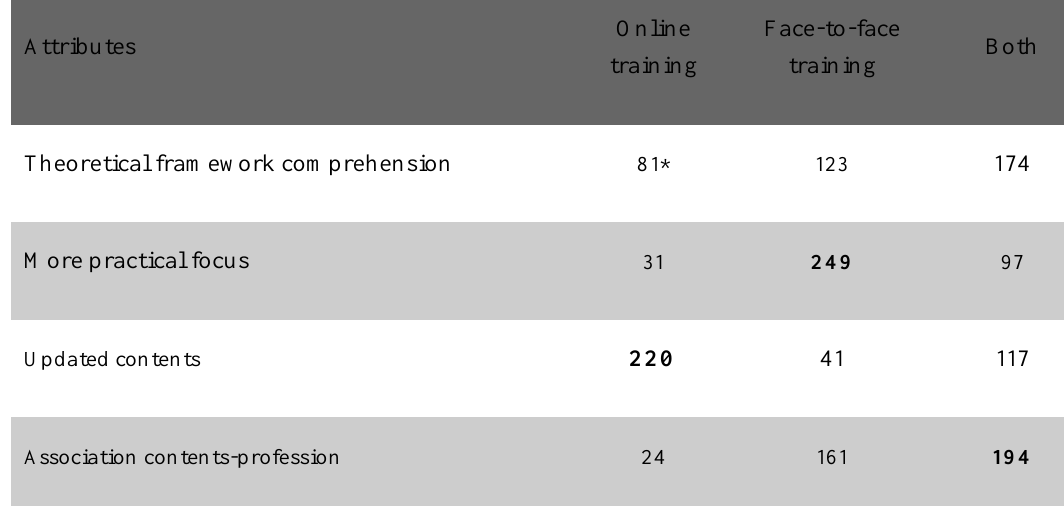
Cross-Tabulated Frequency Data of Attributes Descriptors for Online Training, Face- to-Face Training, and